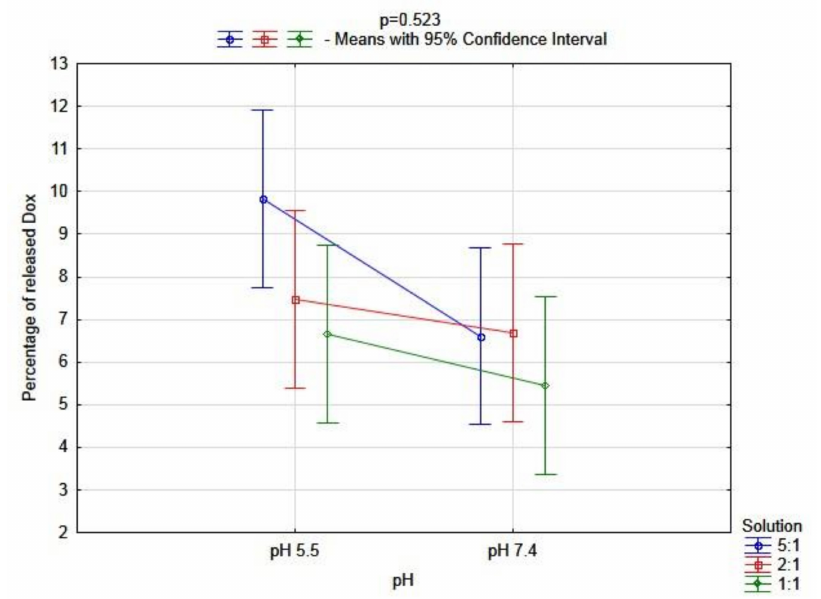
Figure 8. Multivariate analysis of the interaction between pH and molar ratio of CR–Dox on the percentage of the released Dox from the complex (n = 3 for each of S, in pH 5.5: S 5:1, Mean = 9.83 [95%CI: 7.75–11.91], S 2:1, Mean = 7.47 [95%CI: 5.39–9.56], S 1:1, Mean = 6.66 [95%CI: 4.57–8.74]; in pH 7.4: S 5:1, Mean = 6.61 [95%CI: 4.53–8.70], S 2:1, Mean = 6.68 [95%CI: 4–8.77], S 1:1, Mean = 5.45 [95%CI: 3.37–7.53]; n—number of probe; S—solution; 95%CI—95% Confidence Interval).